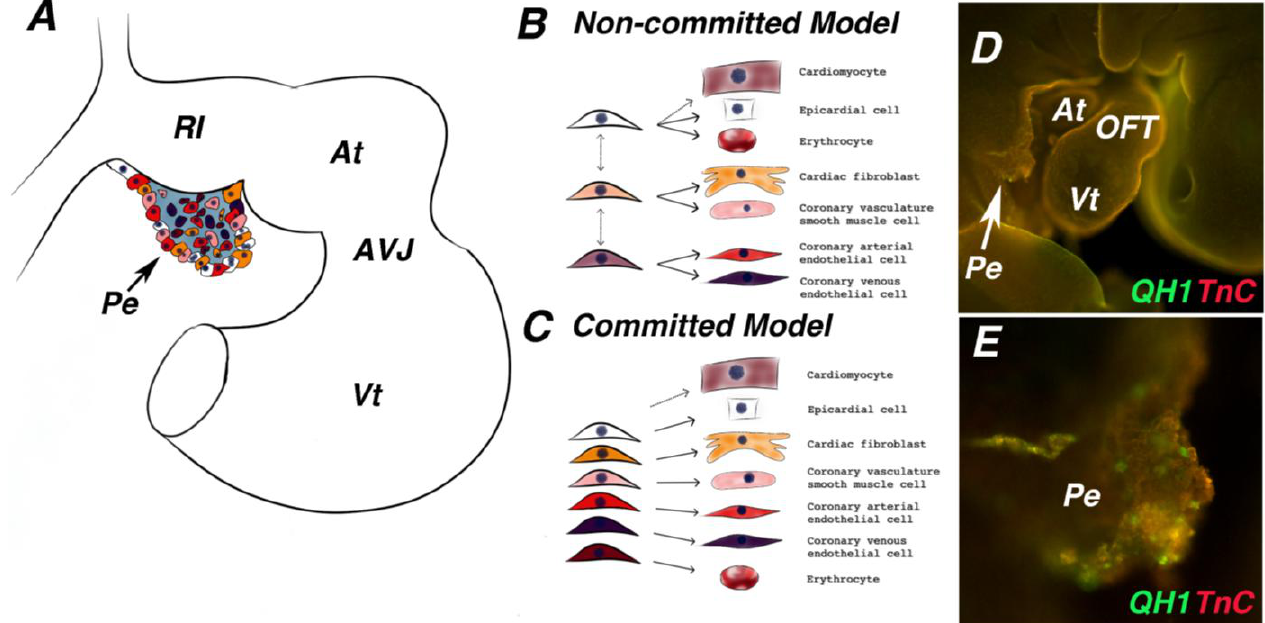
Figure 4. PE cell fate induction. ( A ) Schematic of a late looping stage heart. Different colors in the proepicardium represent different cell fate potentials. ( B ) Model of proepicardium cell fate induction in which cell fates have not been definitively established and individual cells within the proepicardium can go on to give rise to multiple cell types. ( C ) Model of proepicardium cell fate induction in which cells within the proepicardium are already restricted to a cell fate prior to the proepicardium binding to the heart. ( D ) Whole mount immunofluorescence staining of a late looping stage quail embryo stained with antibodies against the extracellular matrix protein, tenascin-C (red), and the quail endothelial marker, QH1 (green). ( E ) Higher magnification image of proepicardium from (D), QH1 positive endothelial cells are clearly present within the proepicardium before it attaches to the heart. At (cid:178)